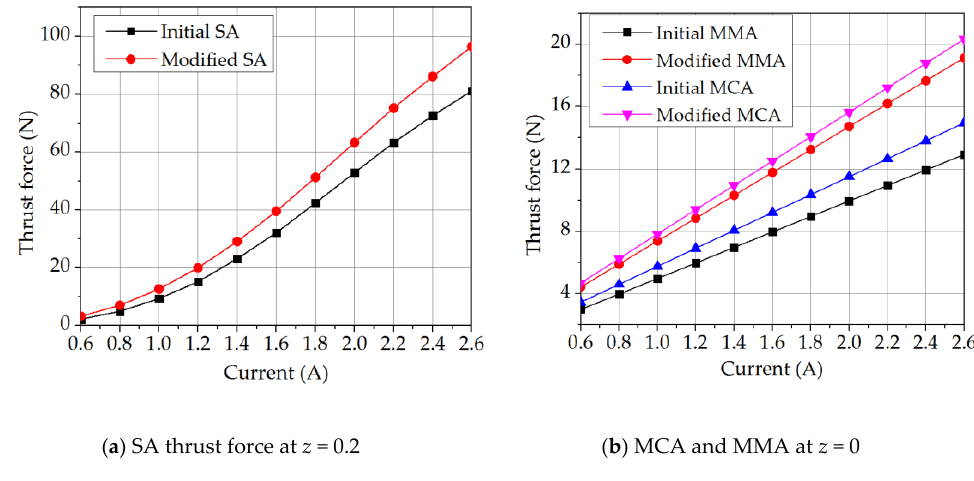
Figure 12. Thrust force of three models before and after modification.